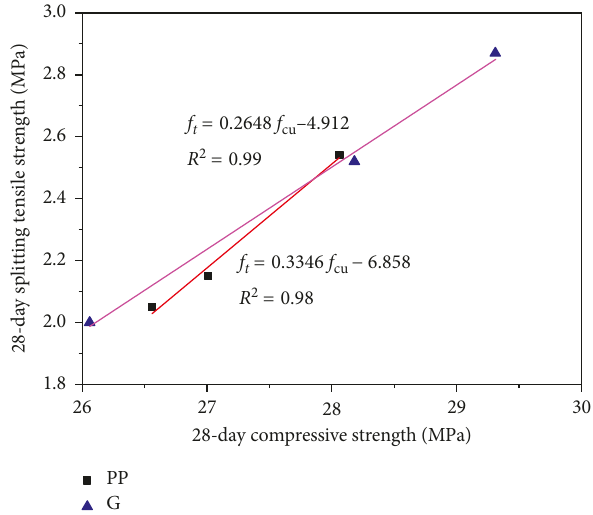
Figure 9: Relationship between the compressive strength and splitting tensile strength.